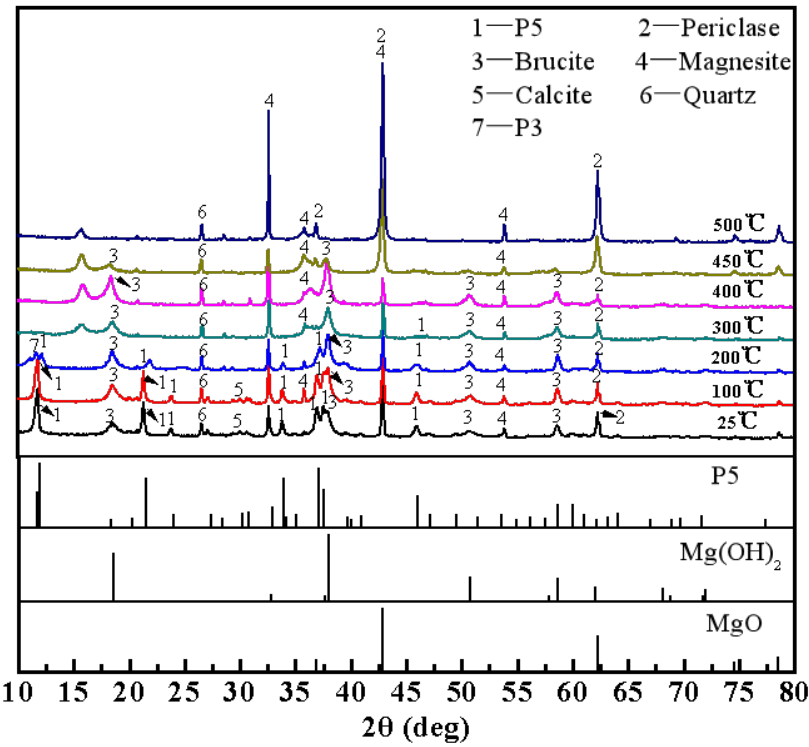
Figure 4. XRD patterns of MOC cured for 28 days at room temperature and calcinated at different temperatures.